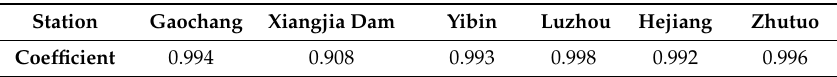
Table 4. Nash–Sutcliffe coefficient of unsteady flow simulations.